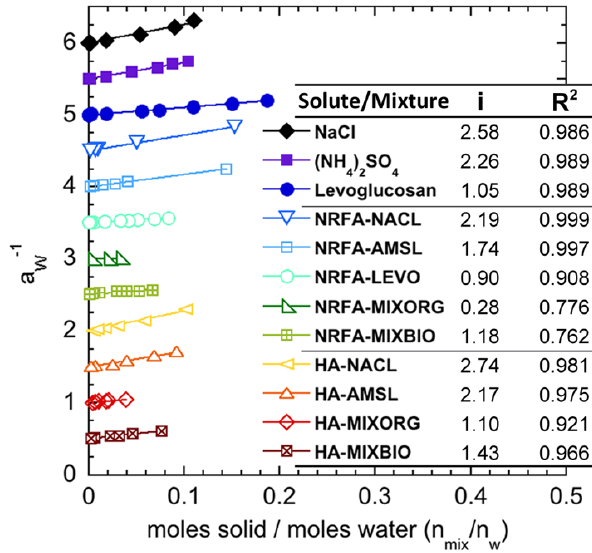
Fig. 4. Water uptake data plotted as the inverse of the water activity ( a − 1 w ) versus the ratio of moles of total dissolved solute to moles of water ( n mix /n w ) for all solutions. A linear fit was applied to each data set. The slope of the line yields the van’t Hoff factor ( i ), which is listed along with the R-squared value for the fit. Each data set was plotted with an a − 1 w offset of 0.5 from the previous one for